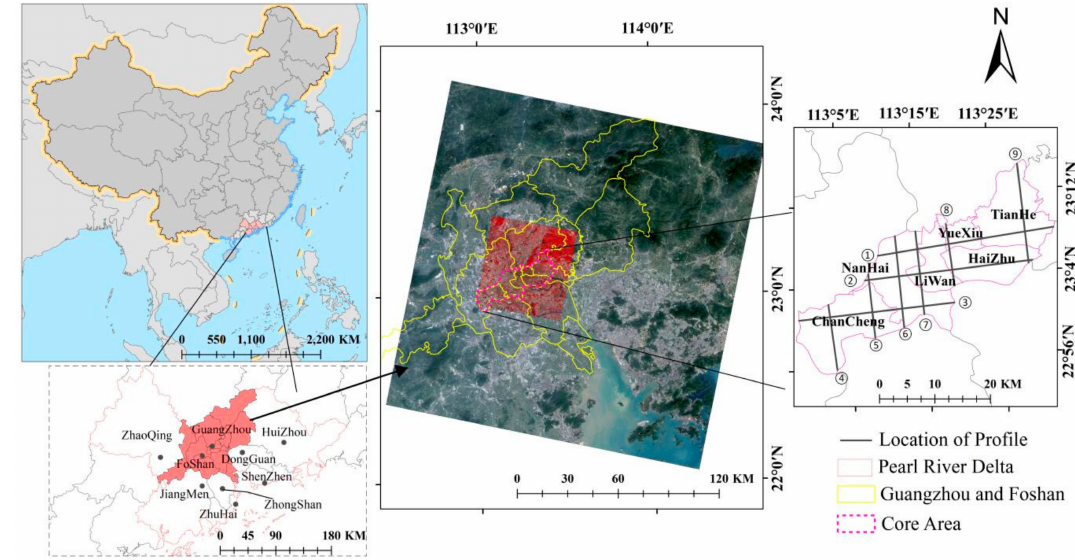
Figure 1. Study areas and satellite data coverage of the Guangzhou-Foshan (GF) in China and locations of profile lines. The data covered consist of the following satellite images (large to small): Landsat 8